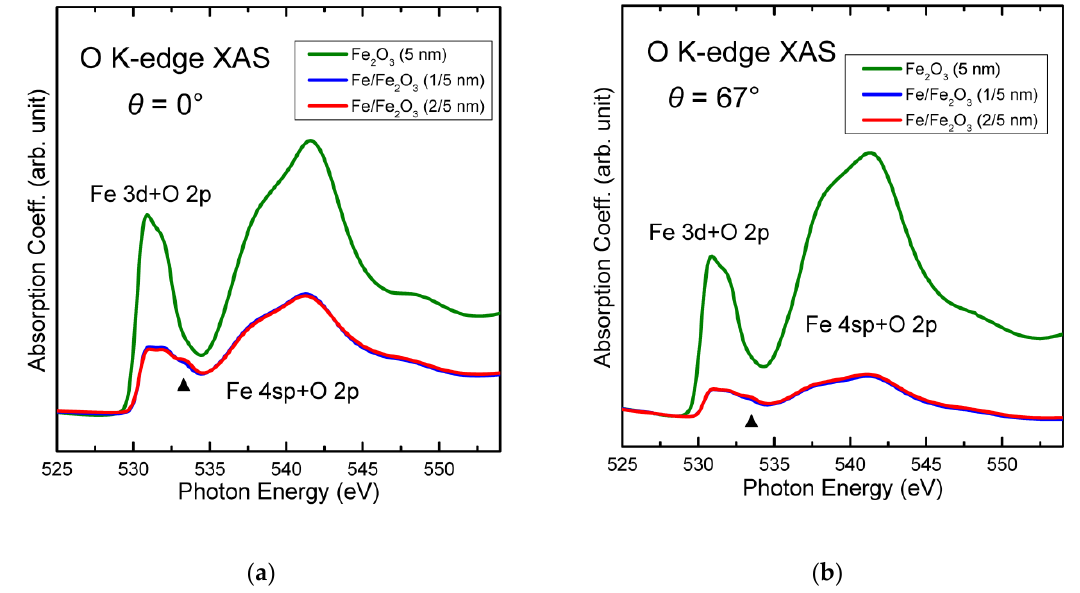
Figure 3. Un-normalized O K-edge XAS spectra taken ( a ) at θ = 0° (beam normal) and ( b ) at θ = 66.5°. Oxidized Fe formed FeO x<1 mainly at the Fe/Fe 2 O 3 interface, which exhibits a fundamentally different electronic structure from ( α+γ )-Fe 2 O 3 .